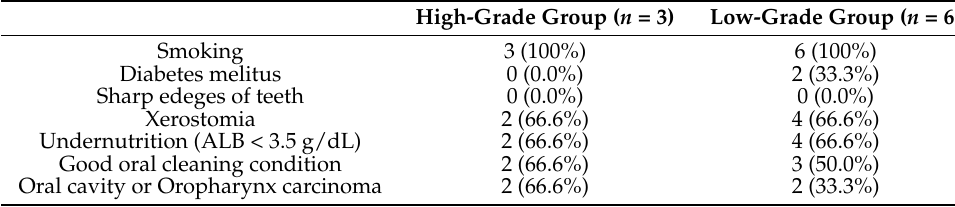
Table 2. Patient characteristics associated with exacerbation of oral mucositis.